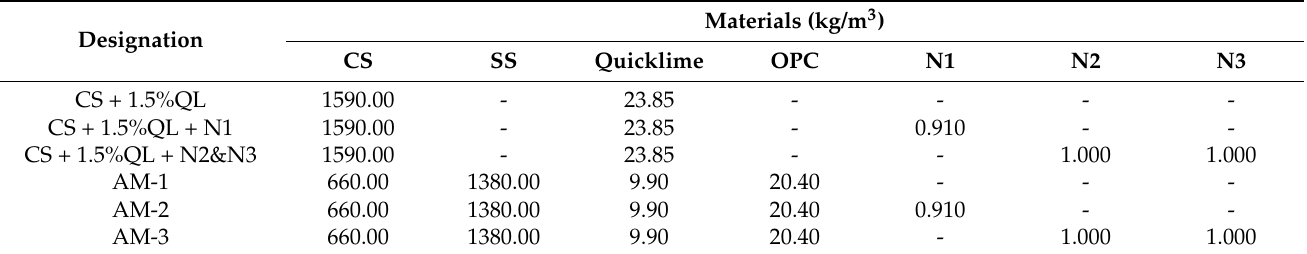
Table 4. Dosages of the